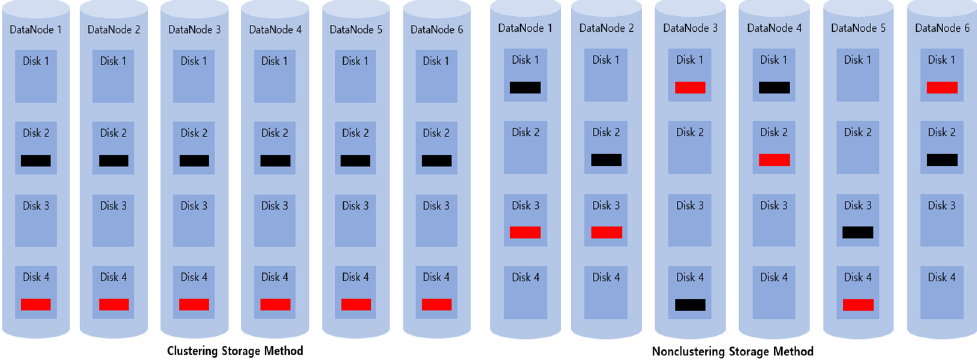
Figure 4. Examples of clustering ( left ) and nonclustering ( right ) storage modes.